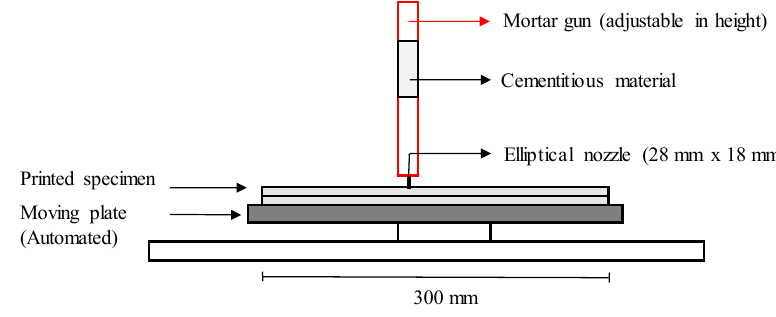
Figure 1. Schematic representation of the 3D print apparatus.